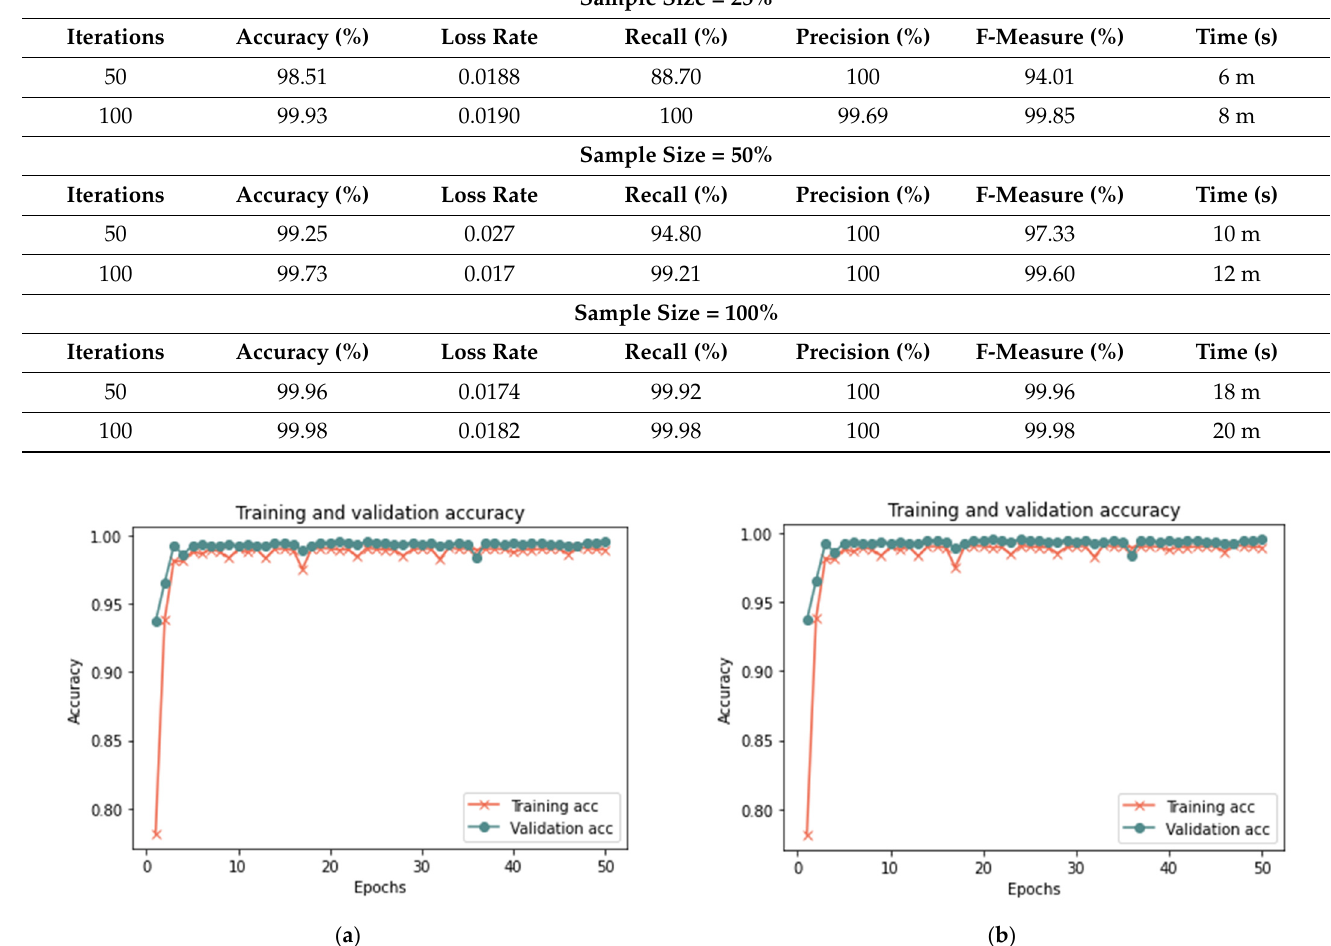
( d ) Figure 14. Results of the second scenario with 50% sample size: ( a ) loss at 50 iterations; ( b ) accuracy at 50 iterations; ( c ) loss at 100 iterations; and ( d ) accuracy at 100 iterations.